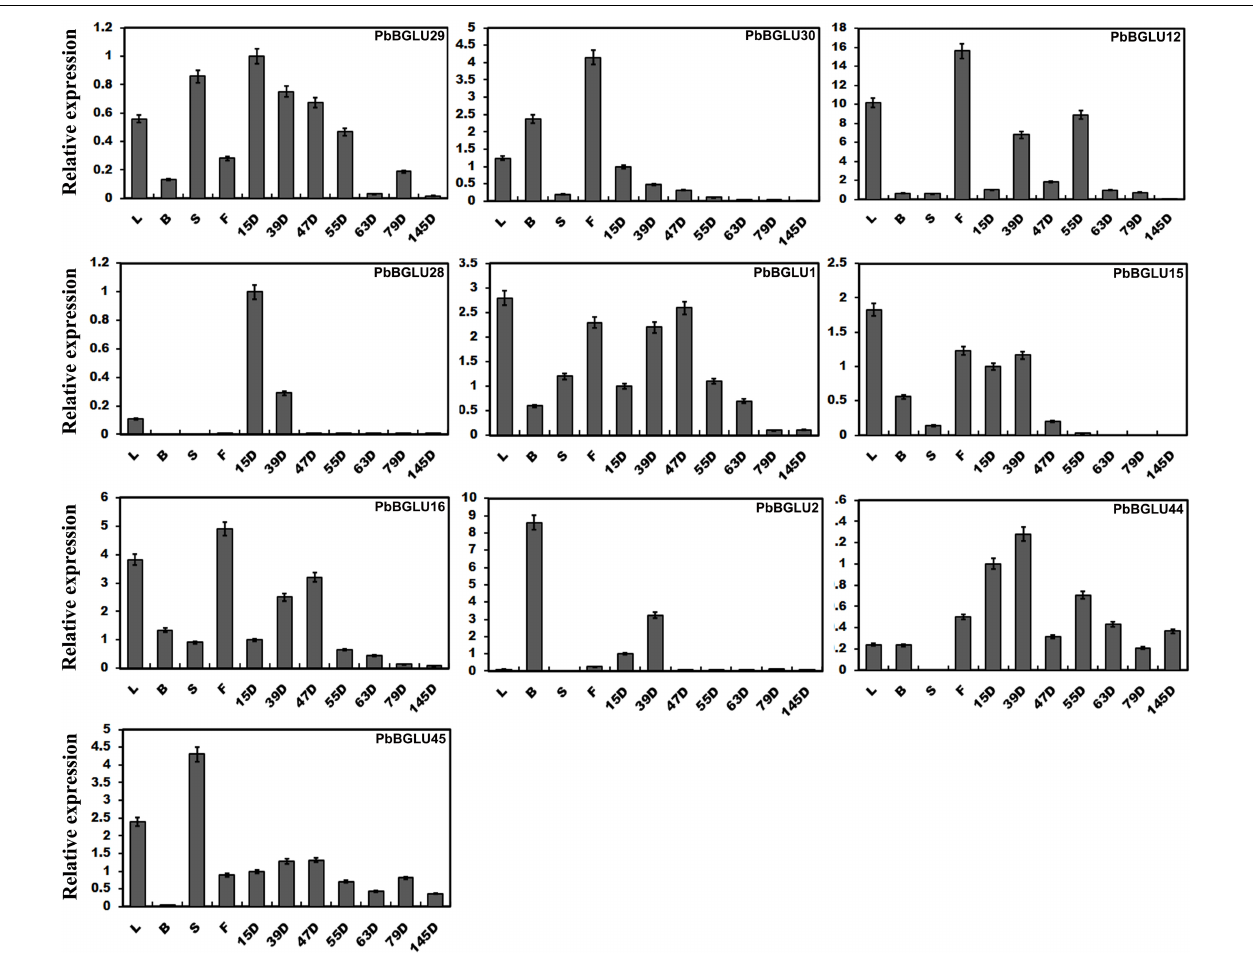
FIGURE 3 | Expression levels of PbBGLU genes in different plant tissues. 15D, 39D, 47D, 55D, 63D, 79D, and 145D correspond to seven different developmental stages (days after flowering) of pear fruit. In addition, leaf, bud, stem, and flower were represented by L, B, S, and F, respectively. The value on the left Y-axis indicates the relative gene expression